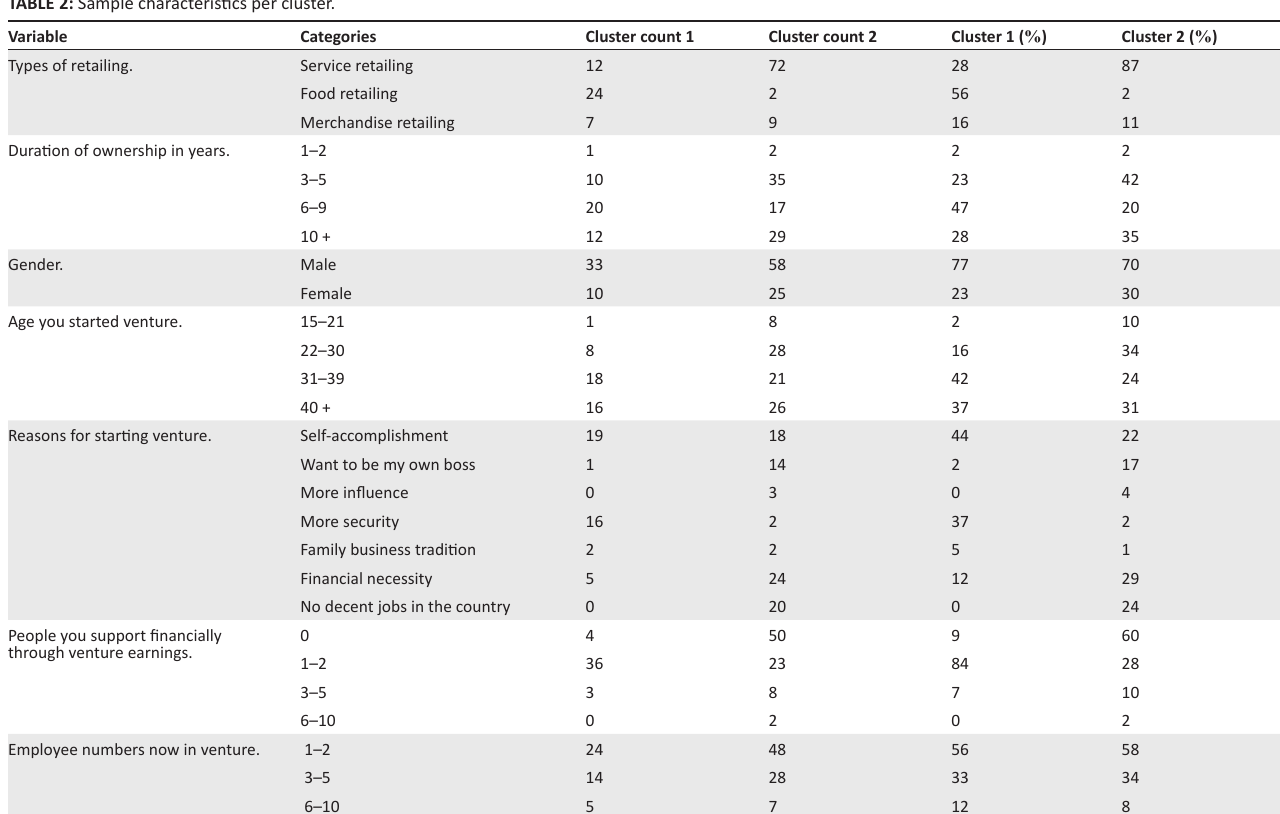
TABLE 1: Descriptives and correlations for variables. Number Work experience. Venture performance. Age of venture. Employees in venture.